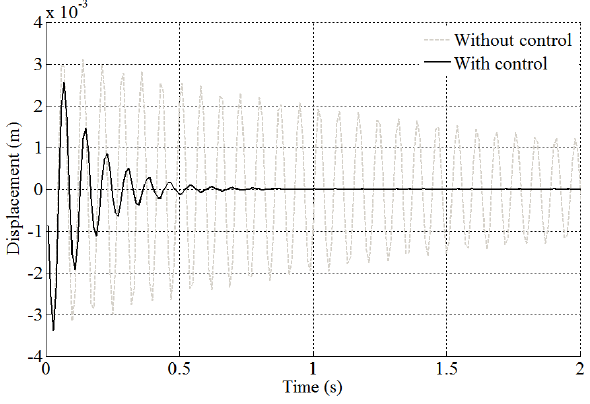
Figure 5: The tip deflection of the beam under transient excitation